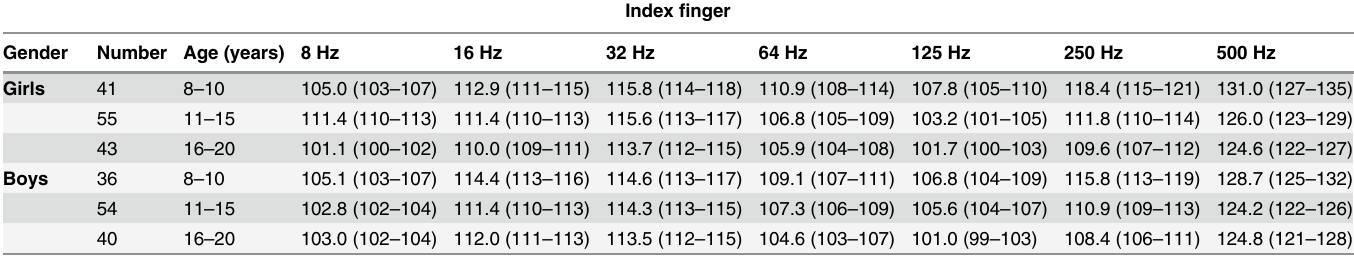
Table 5. Vibration perception thresholds in the finger pulp of index finger at different frequencies in 269 healthy girls and boys.